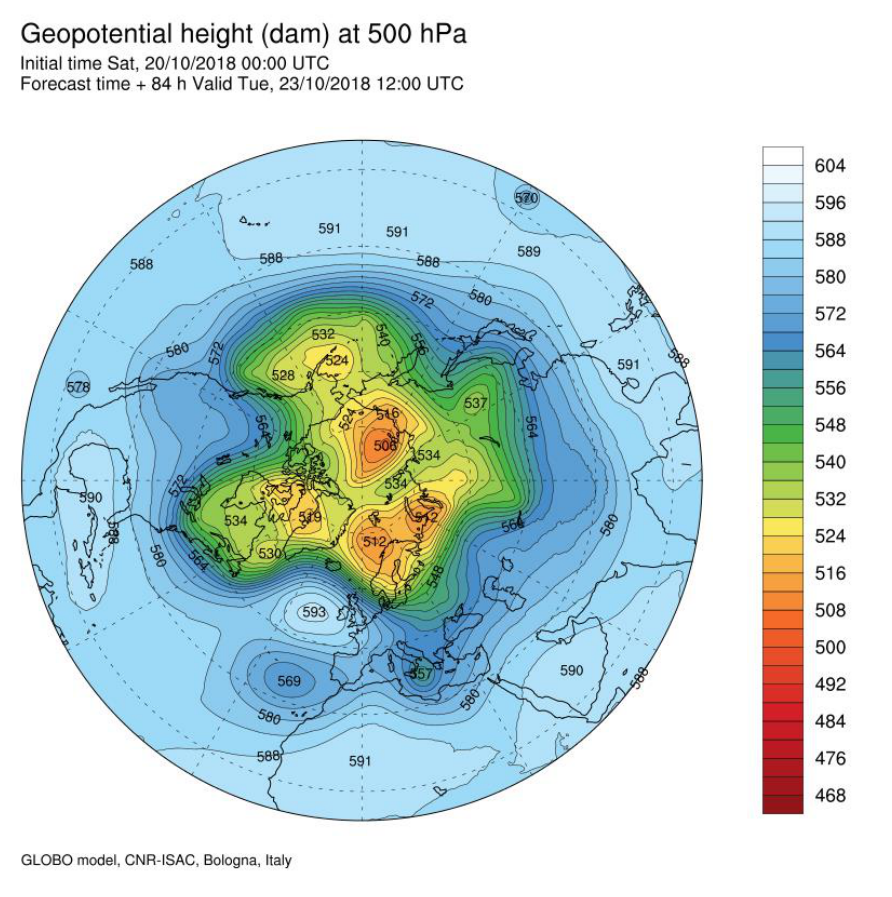
Figure 7. Northern hemisphere map of the 500 hPa GPH associated with the last strong precipitation of the 2018 second flood (i.e., the ID F4 of Table